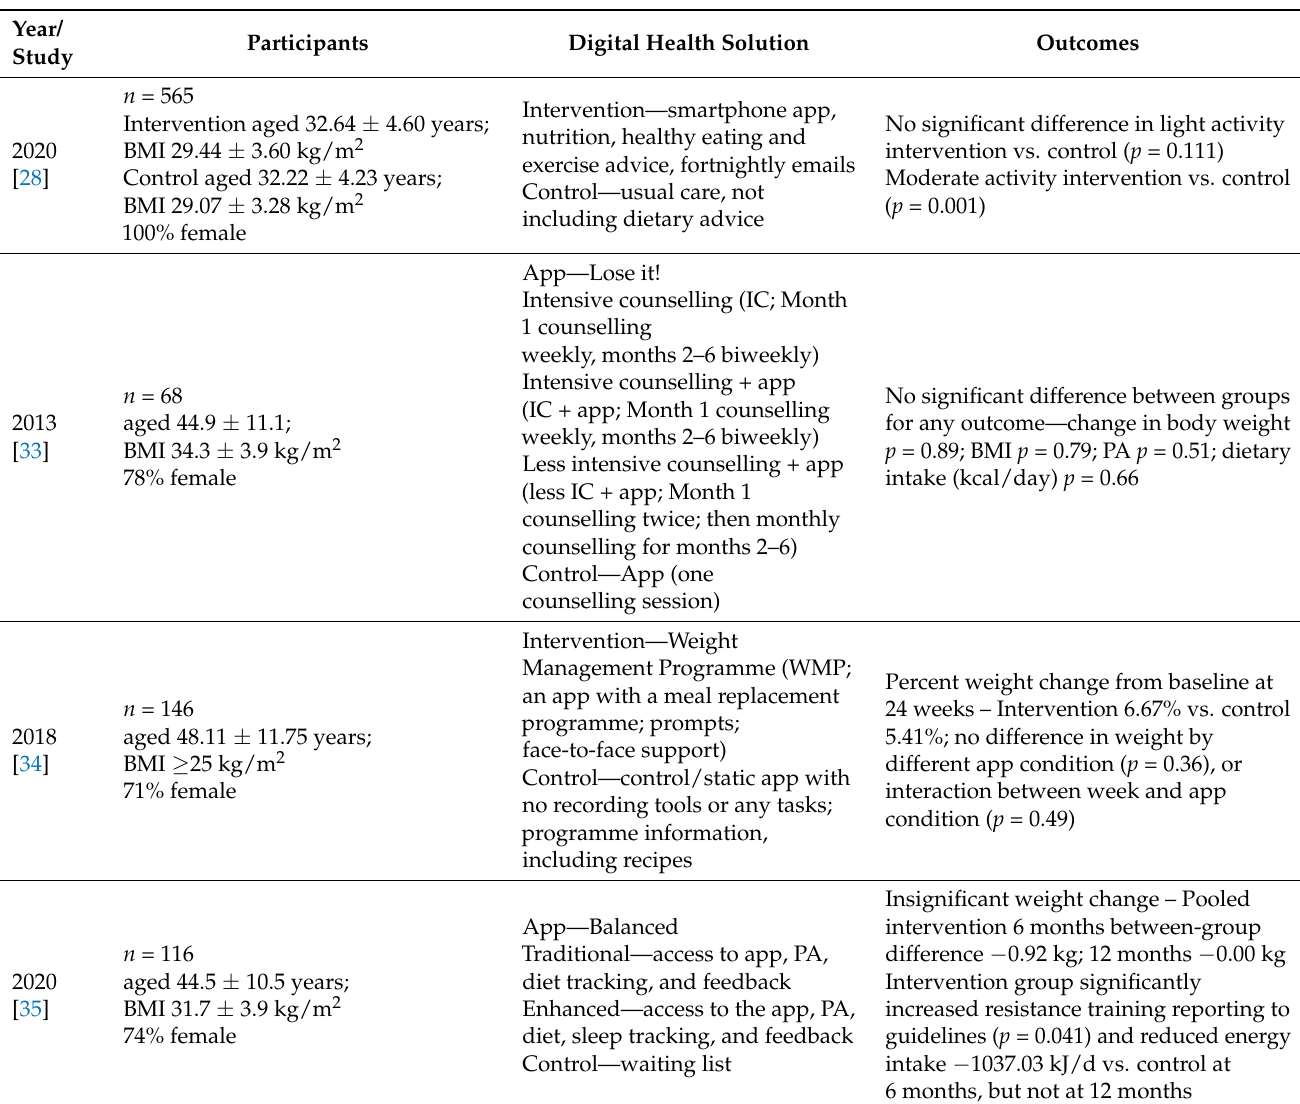
Table 1. Study characteristics for the use of an